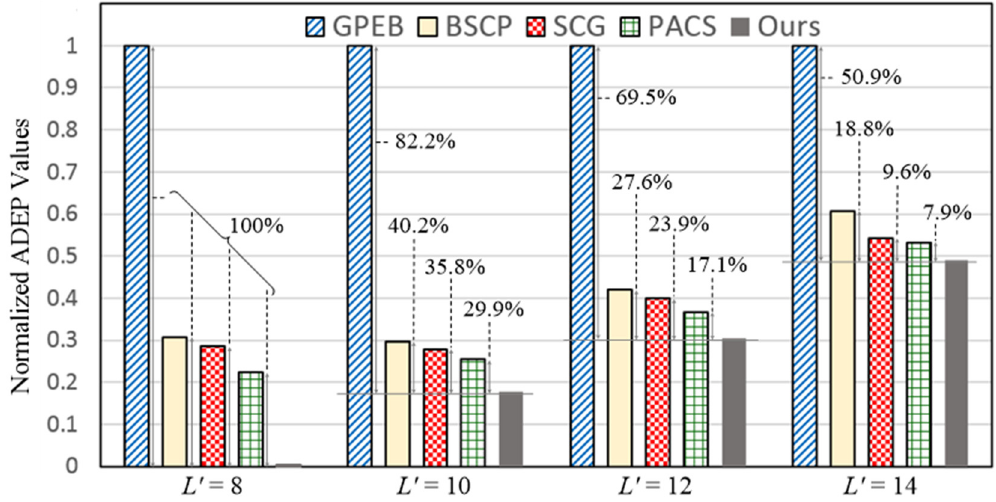
Figure 9. Normalized ADEP values of a 16-bit FWBM for various TEC schemes and L ′